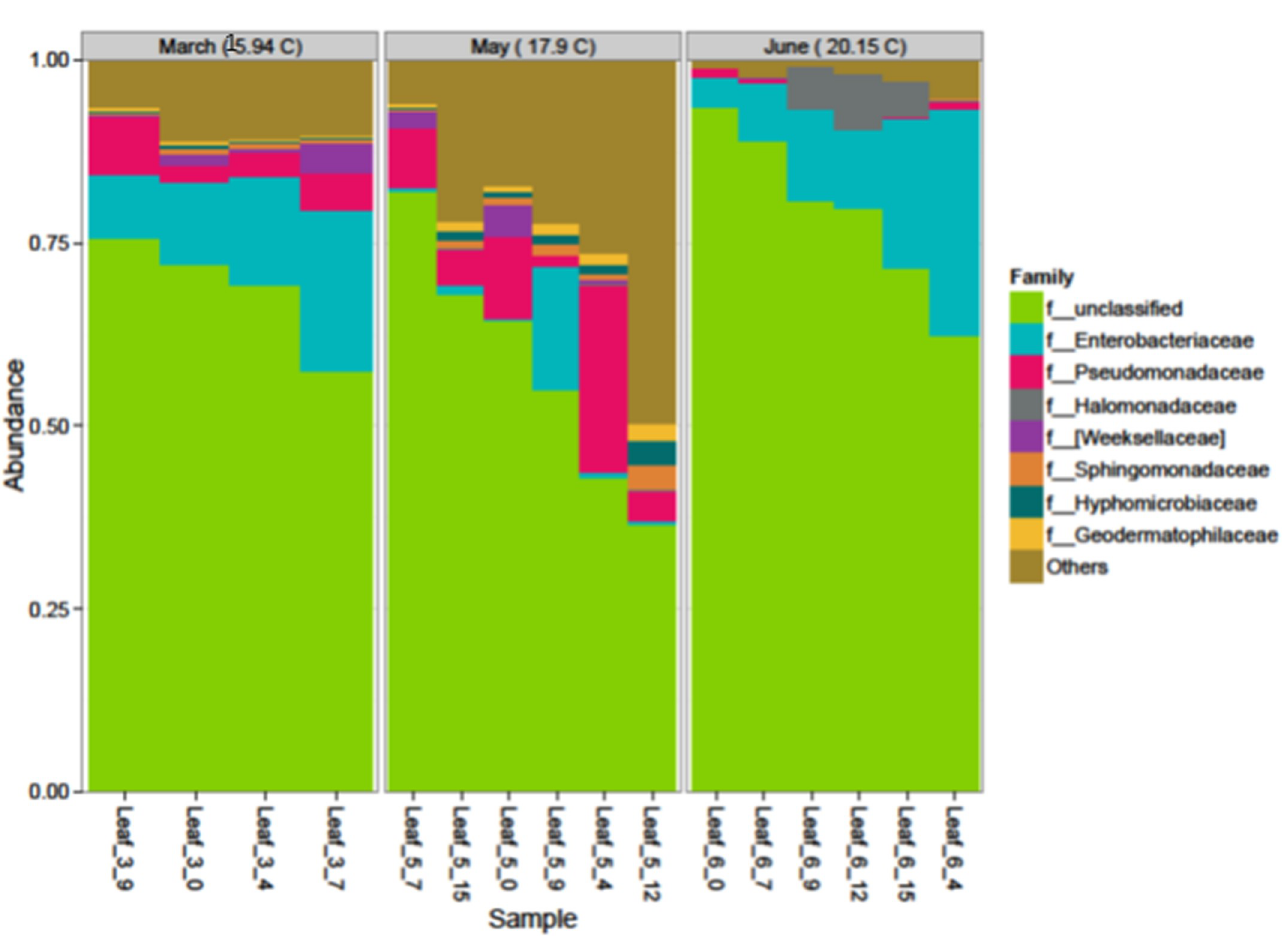
Fig 3. Top 8 most abundant families affected by air temperature during March, May, and June harvesting periods.